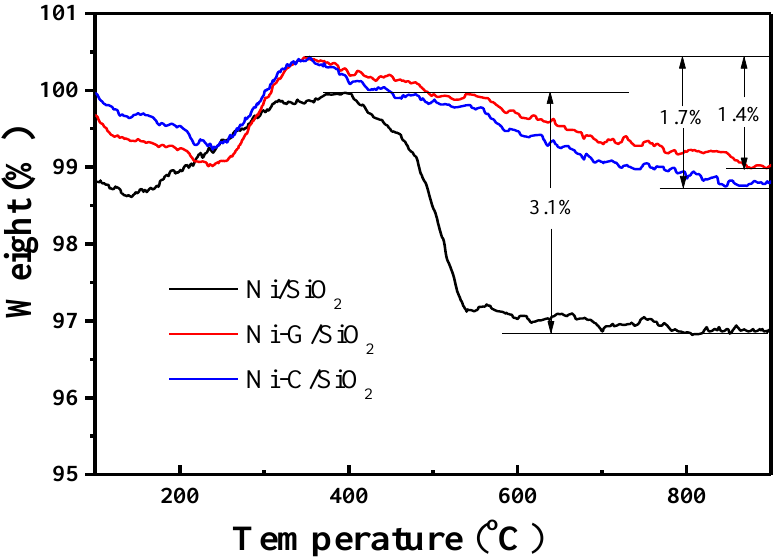
Figure 6. TGA curves for the used catalysts after CDR under the conditions of P = 1.0 atm, T = 750 °C, CH 4 /CO 2 = 1.0, GHSV = 60,000 mL·g −1 ·h −1 , and TOS = 20 h.